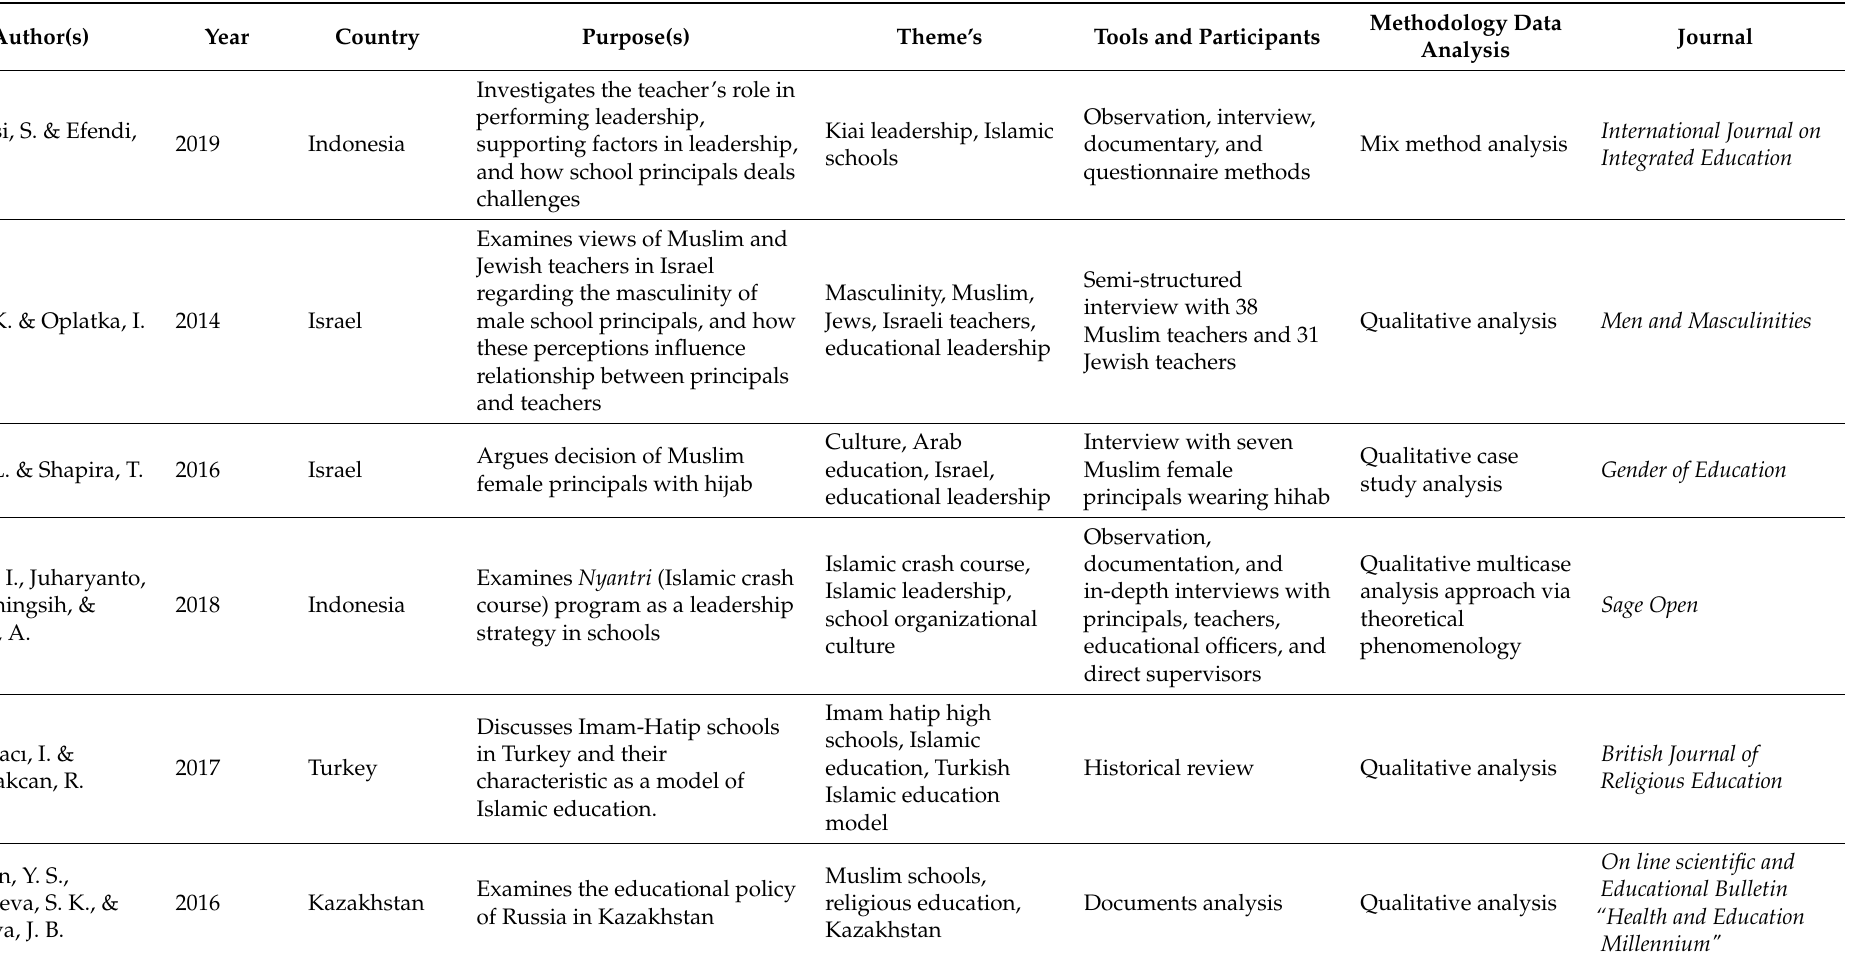
Table 3. Presents the characteristics of the reviewed